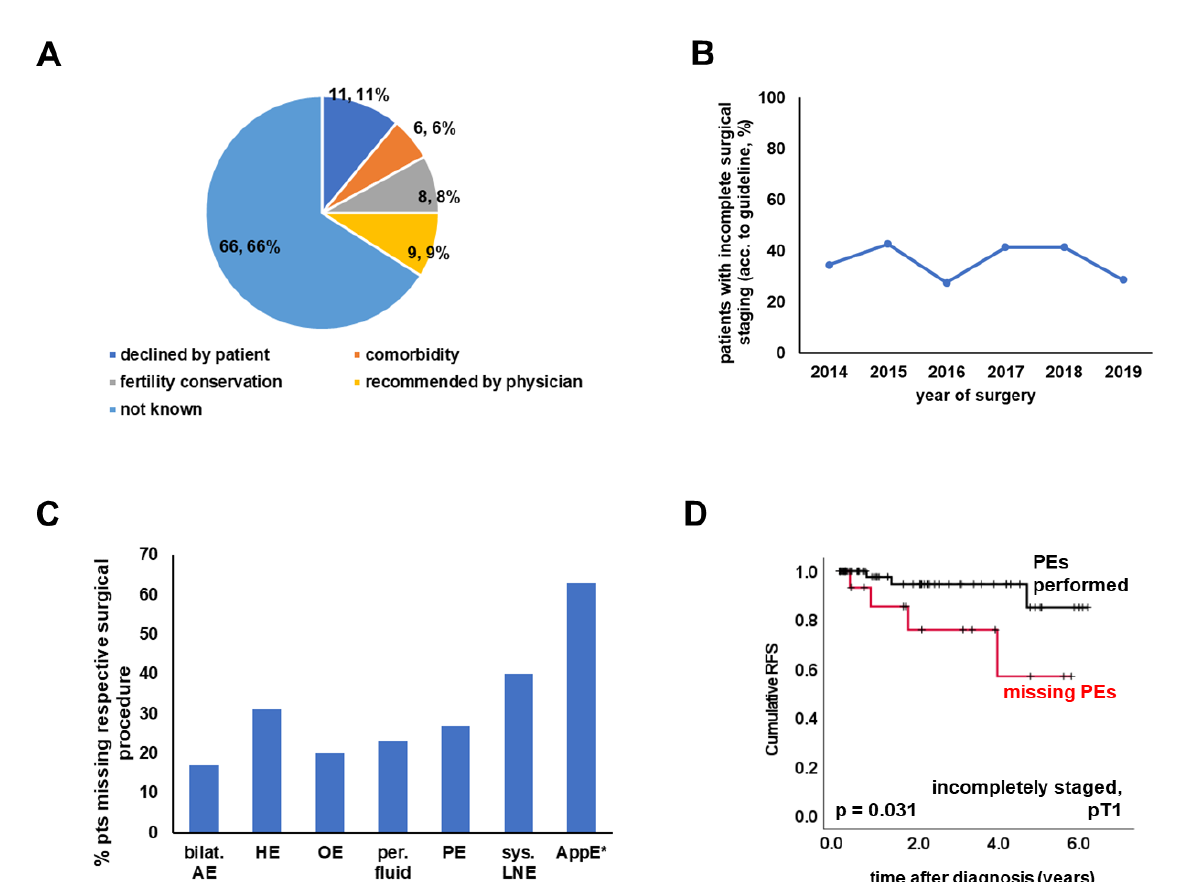
Figure 3. Incompletely Staged Patients. Reasons for incomplete staging are illustrated as a pie chart ( A ). ( B ) shows rate of incomplete surgical staging (i.e., missing at least one surgical procedure recommended, as specified in Materials and Methods) over time. Incompletely staged patients missed at least one surgical step (adnexectomy, hysterectomy, systematic lymphadenectomy (except for mucinous disease graded as G1), omentectomy, peritoneal fluid sampling, peritoneal biopsies ( ≥ 1 biopsy sample), or appendectomy (in the case of mucinous subtype)). How often a certain surgical staging step was missed is depicted in ( C ). Missing peritoneal sampling was associated with reduced RFS in incompletely staged cases with pT stage pT1 ( D , n = 87) but failed to be prognostic in the non-stratified cohort (Supplementary Table S1). Bilat. AE = bilateral adnexectomy; HE = hysterectomy; OE = omentectomy; per.fluid = peritoneal fluid sampling; PE = peritoneal biopsies; sys. LNE = systemic lymphadenectomy; AppE = appendectomy; acc = according; * data from mucinous cases only.